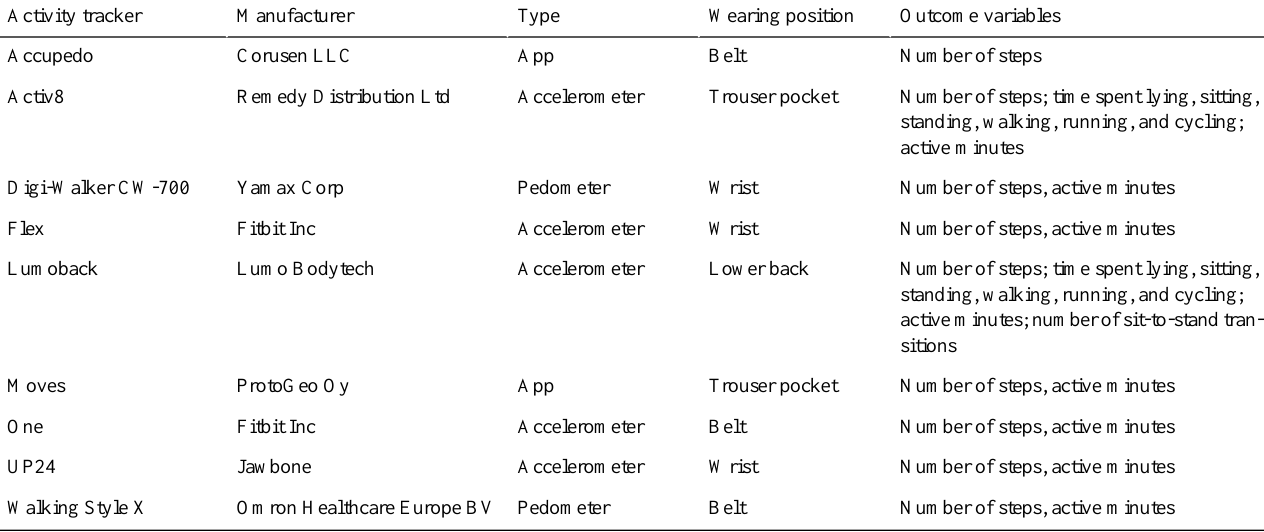
Table 1. Selected commercially available activity trackers used in this validity